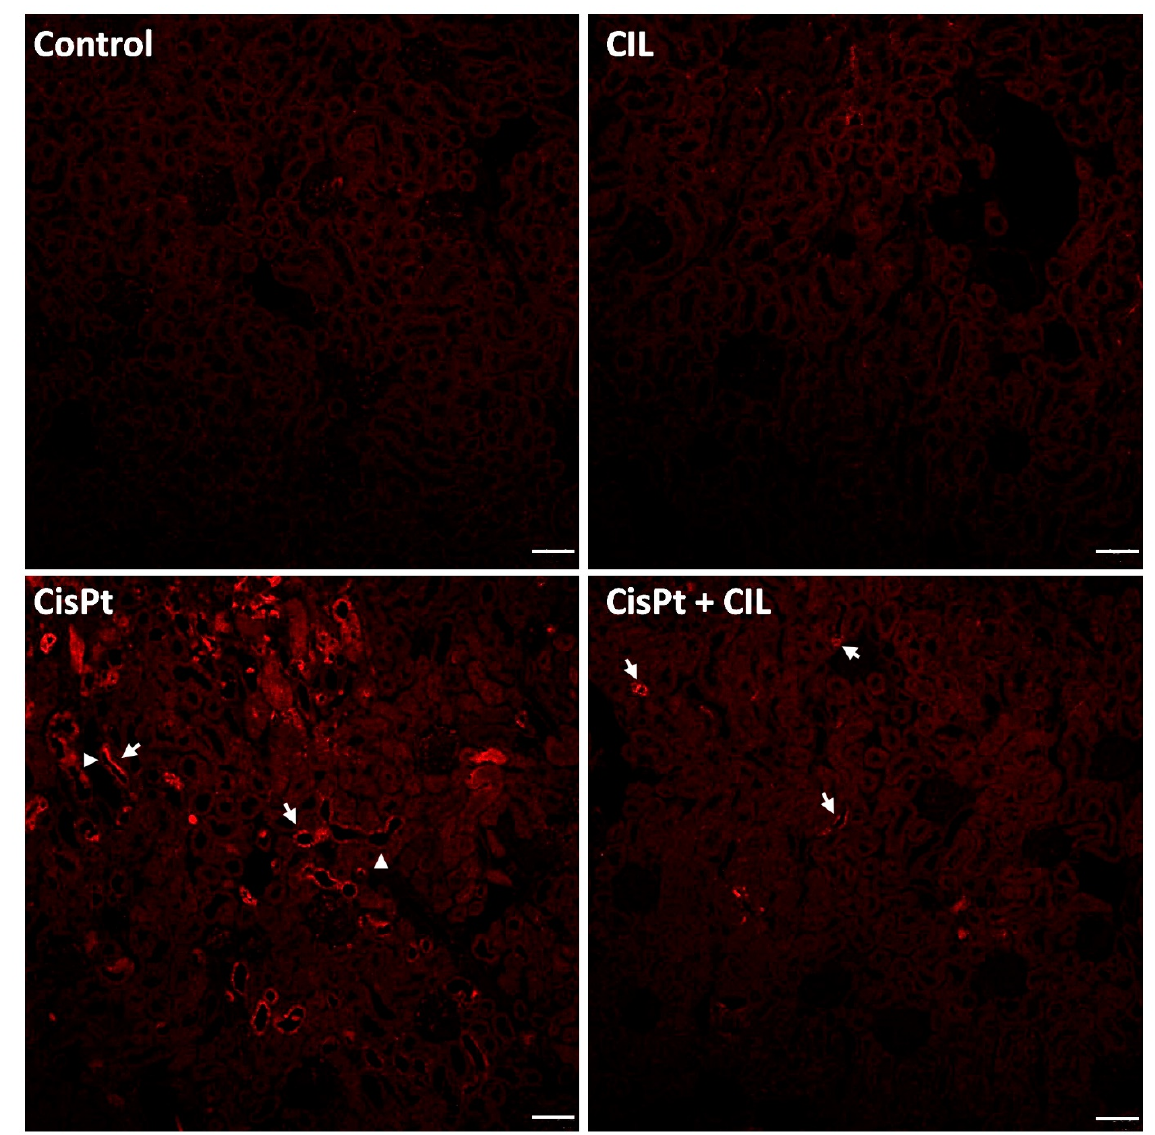
Figure 3. Focal and segmental localization of TNF α expression elicited by cisplatin in rat kidney tubules. Renal tubules of control and cilastatin (CIL)-treated groups show homogeneous basal expression of TNF α . In the cisplatin-treated group (CisPt), immunostaining for TNF α in tubules is heterogeneous, with positivity observed only in some tubules foci (white arrows), and sometimes confined to a segment of the tubule (arrowheads). Cilastatin-protected cisplatin-treated rat kidneys (CisPt-CIL), show scarce immunolocalization signals for TNF α (white arrows). 10 × magnification. Bar = 40 µ